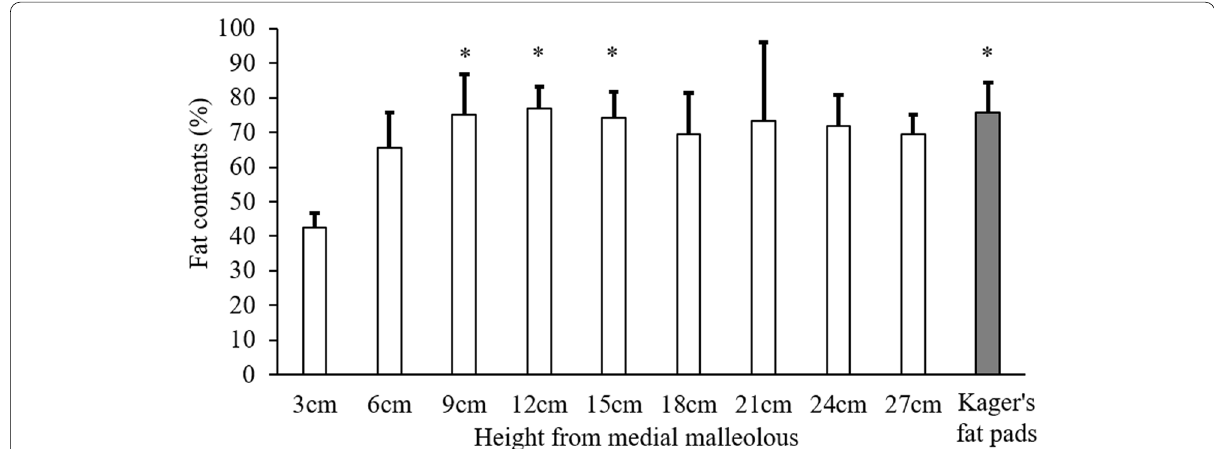
Fig. 5 Fat fraction of the adipose tissue at each height along the posteromedial tibial border and that of Kager’s fat pads. The fat fraction at 6 cm is significantly lower than that at the 9, 12, 15 cm marks and that of Kager’s fat pads ( P < 0.05). The fat fractions at 3 and 27 cm represent measurements from eight and four participants, respectively. *: significant difference compared with the fat fraction at the 6 cm